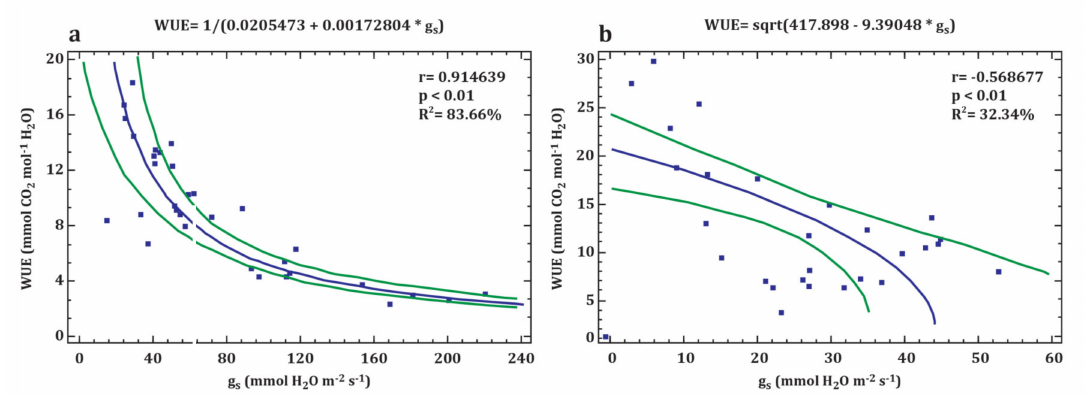
Figure 5. Relationship between the water use e ffi ciency (WUE) and stomatal conductance (g s ) of P. pyraster ( a ) and S. torminalis ( b ) seedlings grown for 50 days under di ff erent water regimes. The plot shows regression curve (blue line) and 95% confidence intervals (green lines). There were species specific responses to drought—a strong relationship was confirmed between WUE and g s for P. pyraster ( 5a ). During the experiment, S. torminalis maintained quite low and balanced values of g s , while the relationship between WUE and g s was insignificant ( 5b ).